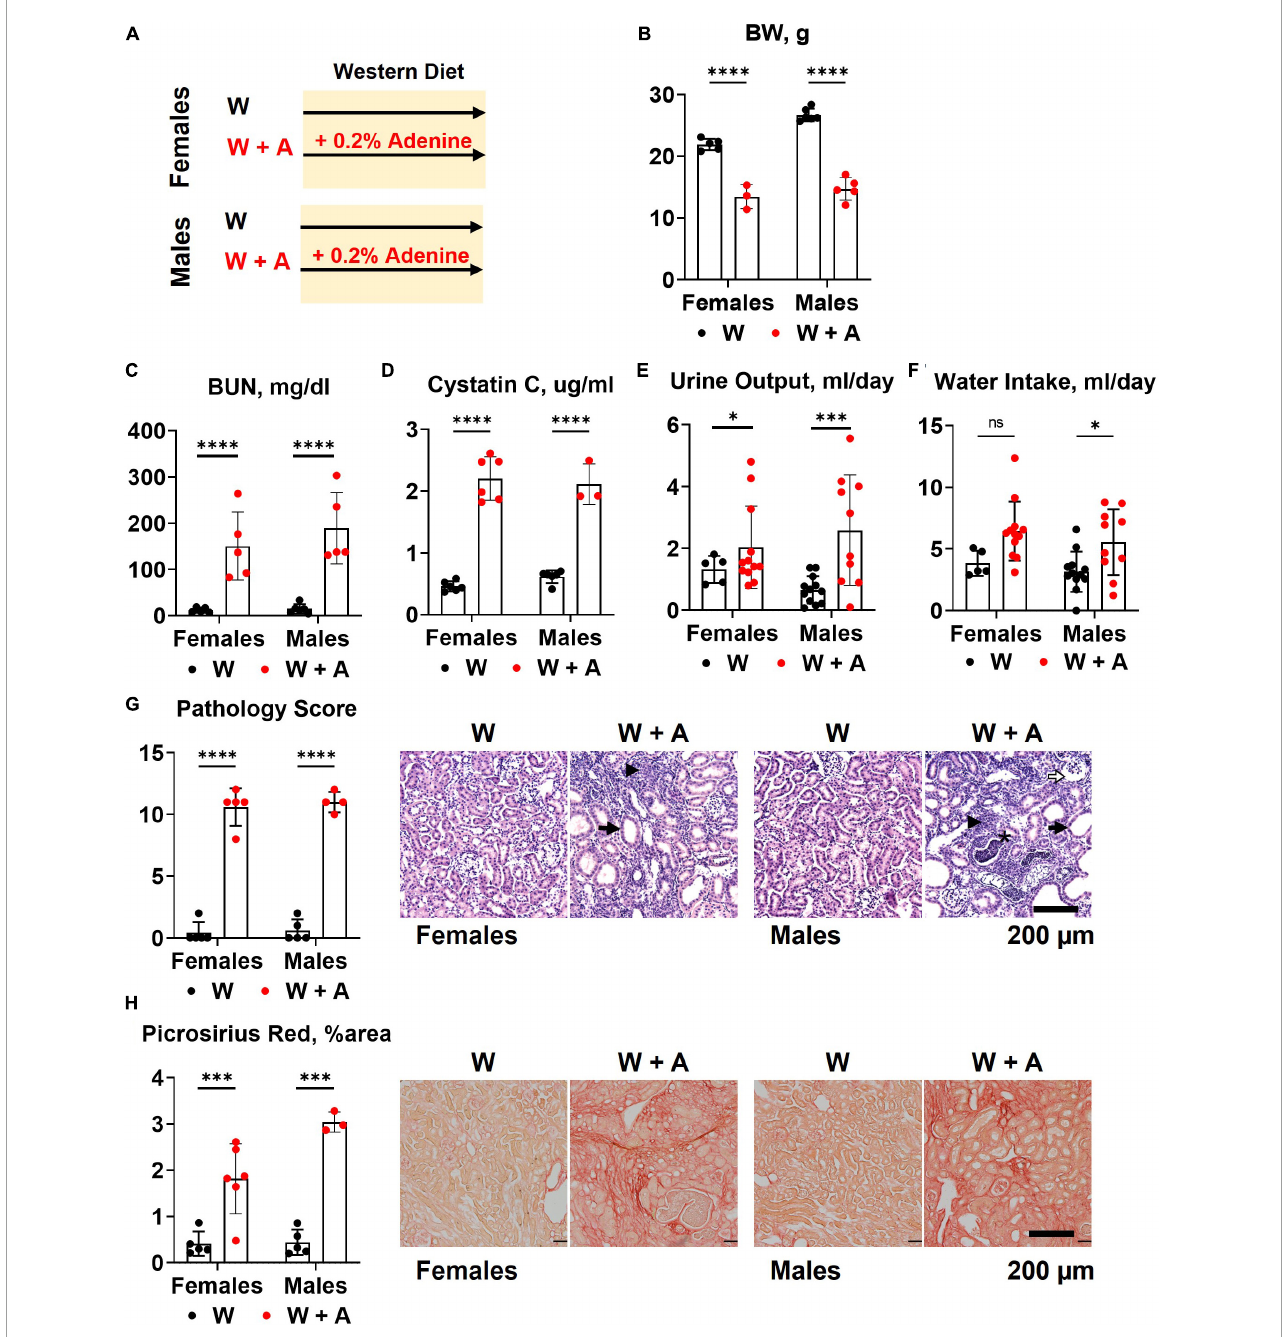
FIGURE1 Chronic kidney disease in WHC mice fed a western diet supplemented with 0.2% adenine. (A) Treatment groups: male and female mice ( n = 6 per group) were treated with a western diet (W) or a western diet supplemented with 0.2% adenine (W + A). (B) Body weight (BW). (C) Blood urea nitrogen (BUN). (D) Plasma Cystatin C. (E) 24-h urine output. (F) 24-h water intake. (G) Renal histology scores and representative images of H&E stained slides; tubular dilatation (arrow), inflammation (arrowhead), pus casts (asterisk), enlarged Bowman’s space (open arrow). (H) Quantification of kidney fibrosis and representative images of picrosirius red staining. n = 4–10 per group; two-way ANOVA; ns, not significant; ∗ p < 0.05; ∗∗∗ p < 0.001; ∗∗∗∗ p <